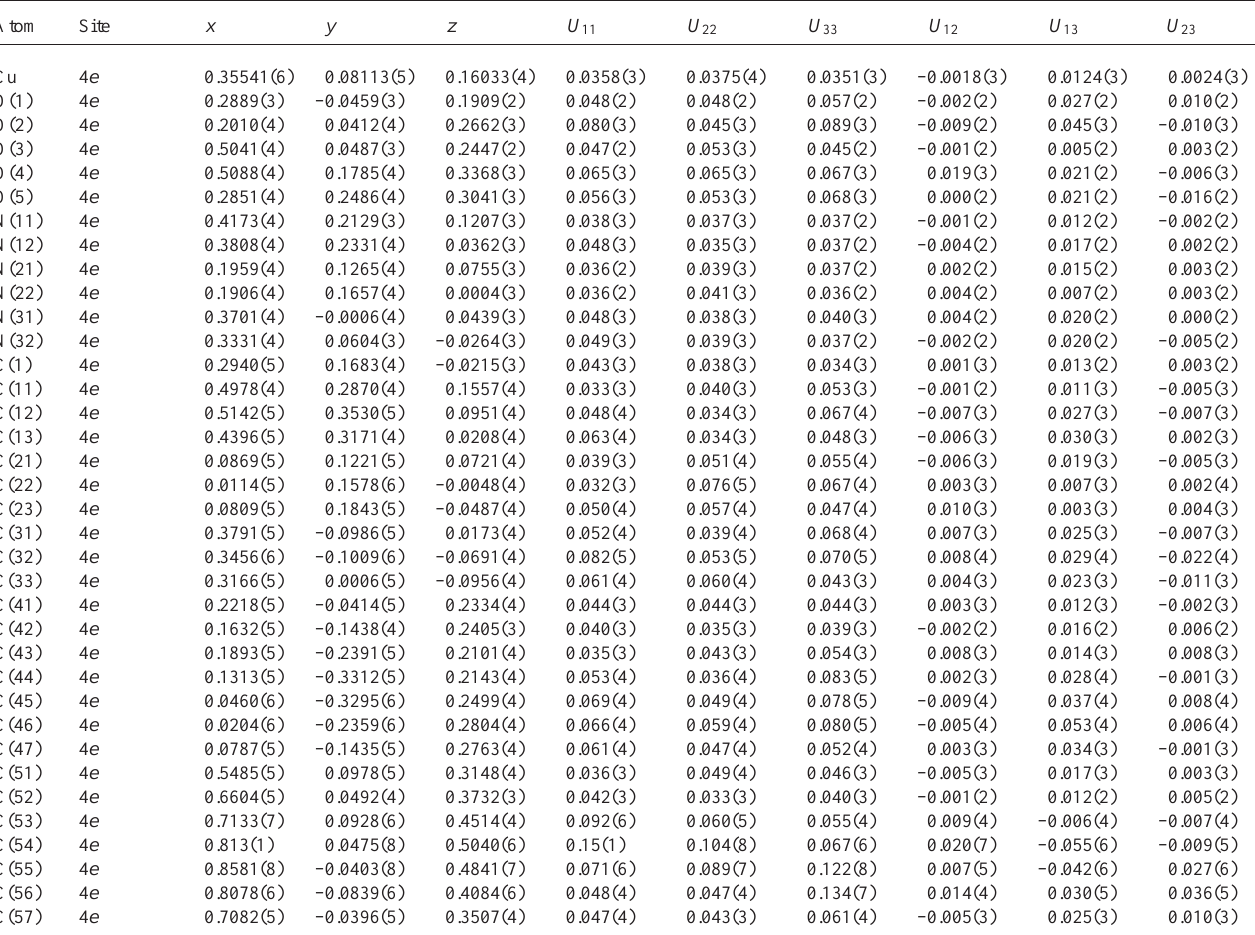
Table 3. Atomic coordinates and displacement parameters (in Å 2 ) .